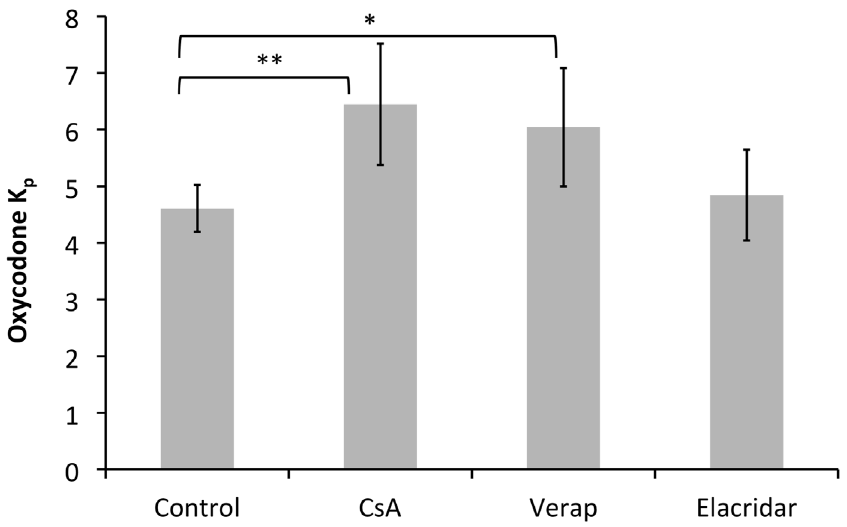
Fig 6. Effect of different P-gp blockers on oxycodone K p in C57BL/6 WT mice (n = 20), ( * p < 0.05, ** p < 0.01). Oxycodone was administered 1 mg/kg subcutaneously. The P-gp blockers were given cyclosporine A 100 mg/kg intraperitoneally, verapamil 3 mg/kg or elacridar 6 mg/kg subcutaneously one hour before the administration of